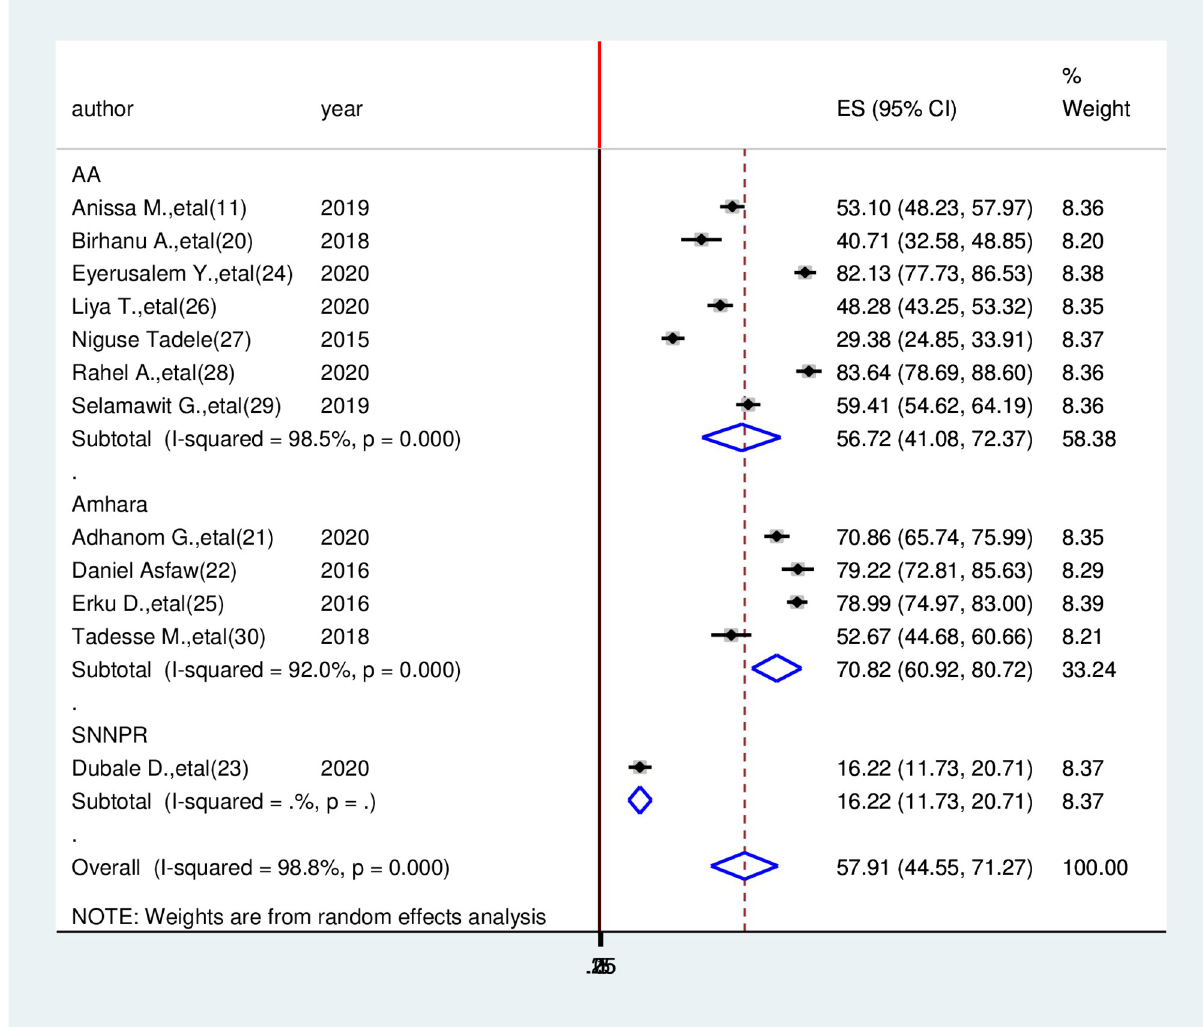
Fig 4. The subgroup analysis done by region for the prevalence of health related quality of life among cancer patients, 2021.